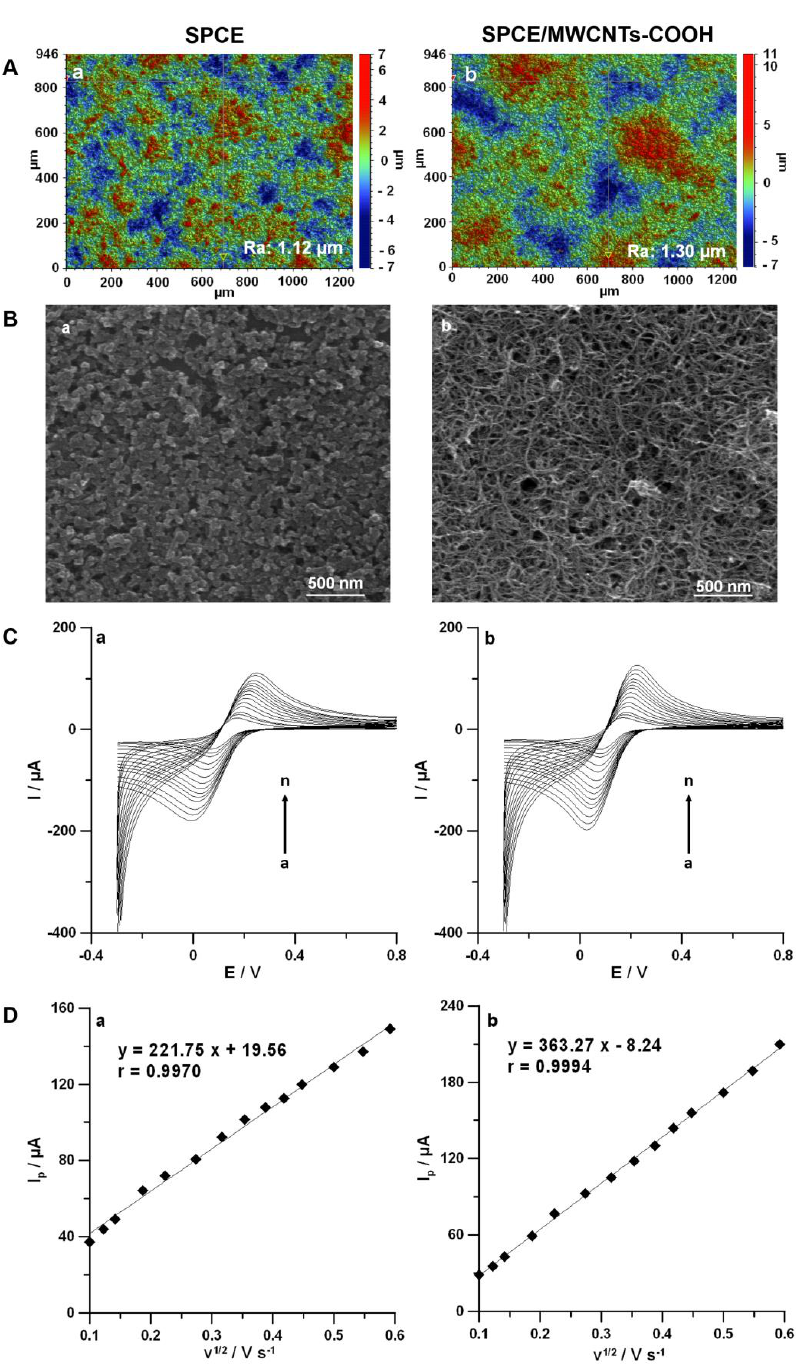
Figure 2. ( A ) Optical profiles. ( B ) SEM images of the SPCE (a) and the SPCE/MWCNTs-COOH (b). ( C ) CV curves recorded at the surfaces of the SPCE (a) and the SPCE/MWCNTs-COOH (b) in a solution of 0.1 mol L −1 KCl containing 5.0 mmol L −1 K 3 [Fe(CN) 6 ] at a ν range of 5–500 mV s −1 . ( D ) Dependences between I p and v 1/2 for the SPCE (a) and the SPCE/MWCNTs (b).